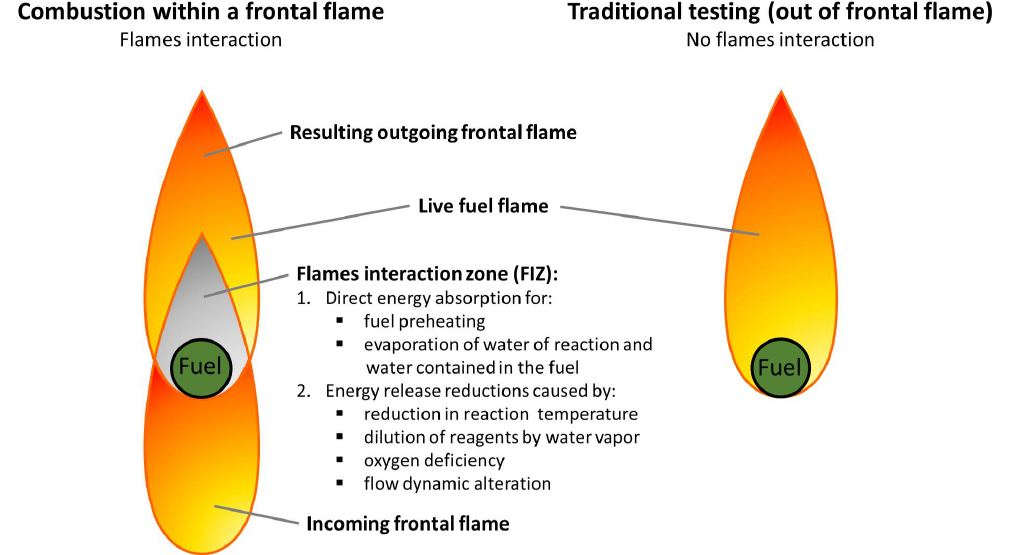
Figure 1. A conceptual diagram of the combustion environment. Left: combustion of a live fuel element in a real wildfire where the live fuel flame interacts with the incoming frontal flame. The region where these flames interact—the flames interaction zone (FIZ)—includes energy release reductions that are unaccounted for by current methods. The vertical direction of flame propagation on the diagram, from bottom to top instead of forward-upward as in real crown fire flame-fronts, represents the experimental setup and apparatus. Right: combustion of a live fuel element in traditional tests out of a frontal flame where the live fuel flame is surrounded by atmospheric air as performed, for example, when measuring effective heat of combustion using standard oxygen consumption calorimetry test setup, e.g.,